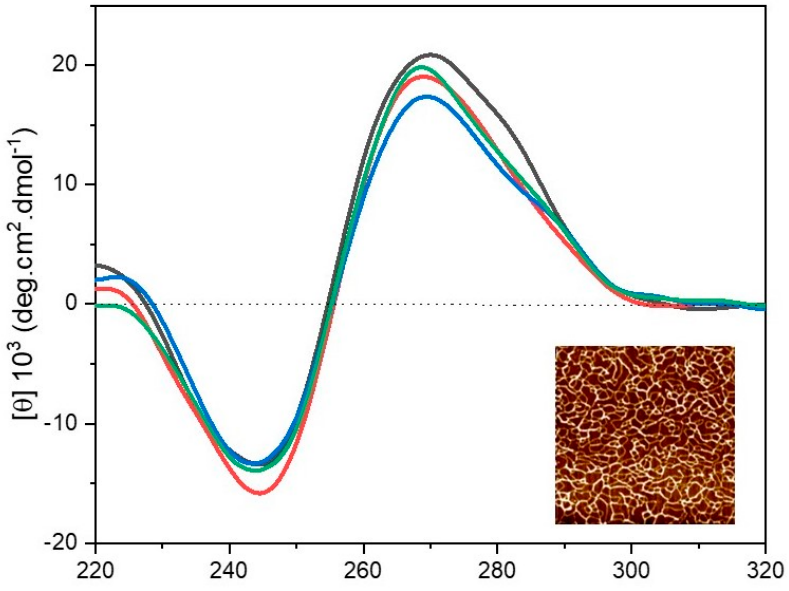
Figure 4. CD spectra of DNA (black), and in the presence of GP12_6 (N/P = 1 red, N/P = 0.5 blue, N/P = 0.25 green). In the insert: AFM image for N/P = 0.5 (see also Figure 3).